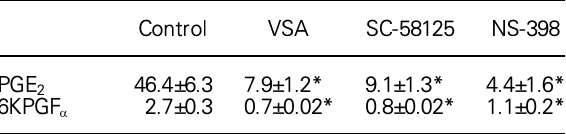
Table 1. The effect of cyclooxygenase 1 and 2 inhibitors on unstimulated prostaglandin E2 and prostacyclin (6-keto